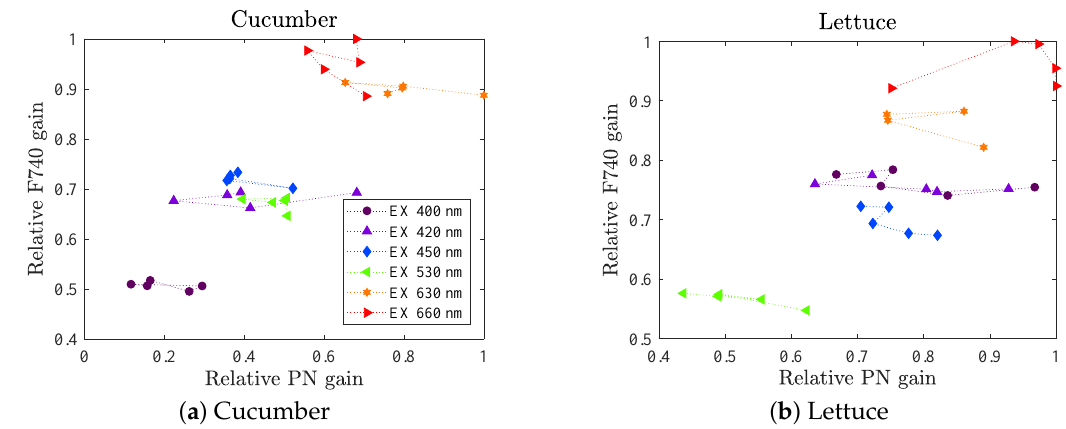
Figure A3. Fluorescence gain vs. photosynthetic rate gain for background light 160µmolm − 2 s − 1 (set A), i.e., combining Figures 6 and 9. The five points of each colour correspond to the five different background spectra (50–100% red light), and the colour indicates the colour of the added excitation light. The variability in the PN data is higher than in the F740